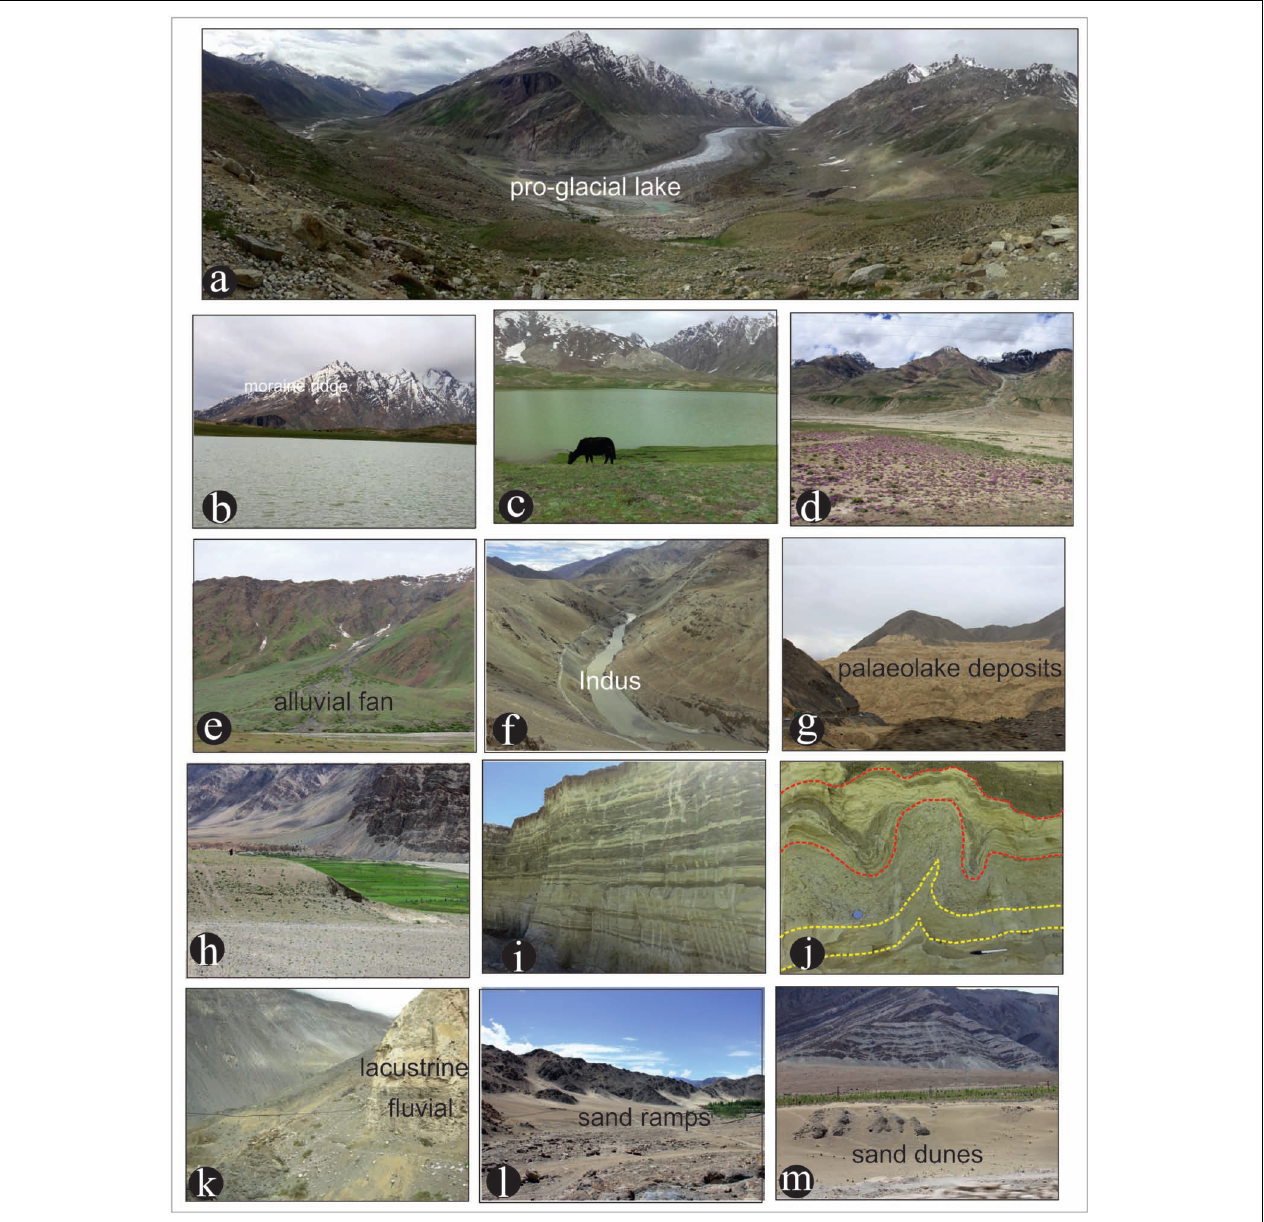
FIGURE 2 | Field photographs are showing the geomorphological features and overall landscape of the Ladakh and Spiti regions of NW Himalaya. (a) A Synoptic view of the Zanskar valley, a typical valley glacier (Photograph was taken from Penzi La), showing the Drang- Drung glacier. The curvilinear, recessional latero-frontal moraines present in front of the glacier snout have been dated to 4.8 ± 0.4 ka (Ali et al., 2018). The broad U shaped Zanskar valley is a manifestation of glacial erosion in the past. (b,c) Field photographs taken at Penzi-La (La = Pass; ∼ 4400 m asl) showing some recessional moraines and a high altitude lake supported by glacial meltwater. (d) At Padum village, the Zanskar valley has preserved the traces of right lateral moraine corresponding to the oldest stage of glaciation (stratigraphically). The meltwater stream coming from the tributary valleys have cut across this moraine and form the fans in the trunk valley. Younger moraines also seen along the tributary glacier valleys. (e) A huge alluvial fan emanating from the left slope and extending into the Zanskar valley. (f) Narrow gorge along the Indus River between Leh and Nimu in Ladakh. (g) Synoptic view of the Lamayuru palaeolake deposits in the Ladakh region. (h) Field photograph taken along the Zanskar valley (downstream of Padum) showing that the vegetation is restricted to the river valley, however, mountains are almost barren and blanketed by the weathered rock material, a very common freeze and thaw process responsible for breaking (physically/mechanically) the rocks into finer detritus. (i) One among many, fluvio-lacustrine deposit present near the confluence of Doda and Tsarp rivers near Padum. Such deposits are a direct manifestation and evidence of river impounding. The relict lake deposits also seen at many places along the Zanskar valley. (j) Close-up of the relict lake sequence showing well developed Synsedimentary/seismic deformation (shown by yellow dotted lines) and ice wedges (shown in red dotted lines). (k) A well-preserved relict lake section showing a sharp contact between fluvial and lacustrine facies near the Nako Village (Spiti Valley) and samples were collected for multiproxy studies. The lake section is around 100 m thick, and we have collected 9 OSL samples for dating the section and 660 samples for palaeoclimatic reconstruction; and (l,m) Field photograph showing sand accumulation by the dry winds near Leh.